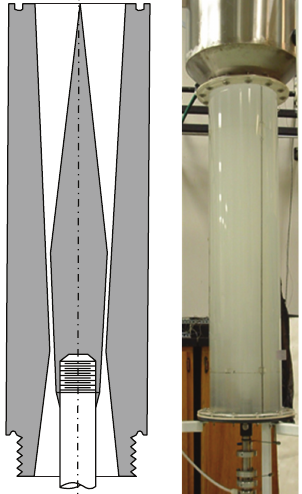
Figure 3: Schematic representation of the two-phase transonic sparger and its use to generate fine bubble dispersions ( U G = 0 . 01ms − 1